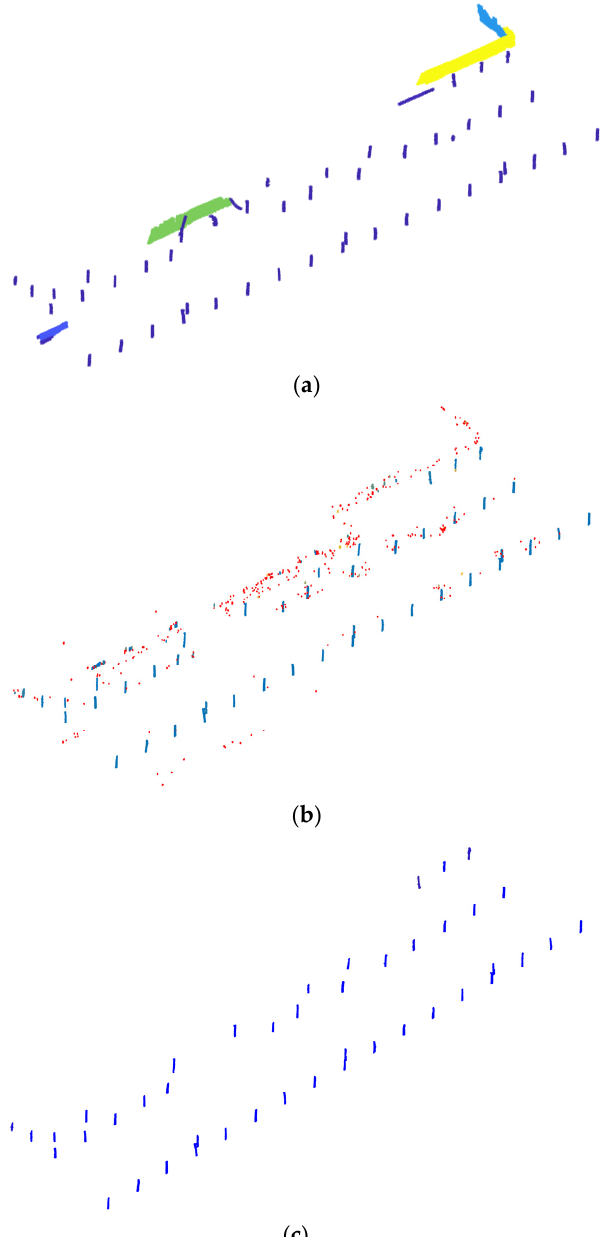
Figure 11. Stem extraction results obtained by different spatial geometric features: ( a ) only linearity constraint is used for stem extraction; ( b ) only H-W radio constraint is used for stem extraction; ( c ) both linearity and H-W radio constraints are used for stem extraction.